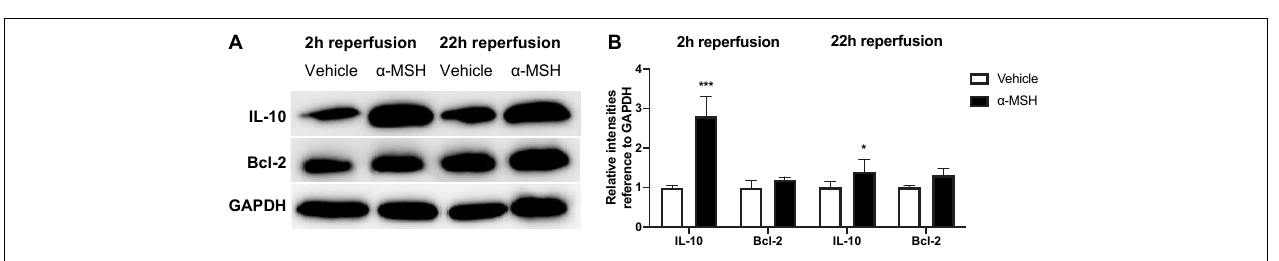
FIGURE 5 | α -MSH decreased the oxidative and nitrative stress after I/R injury. (A–D) Significantly weaker PAR immunoreactivity was observed in animals treated with α -MSH at 2 h of reperfusion. This immunoreactivity was comparable at 22 h of reperfusion. (E) IHC scores for PAR. (F–I) Weaker NT immunoreactivity was observed in α -MSH-treated animals in both experimental conditions. (J) IHC scores for NT. ** P < 0.01, Mann-Whitney U -Test, n = 6 for each group. Scale bar = 25 µ m.